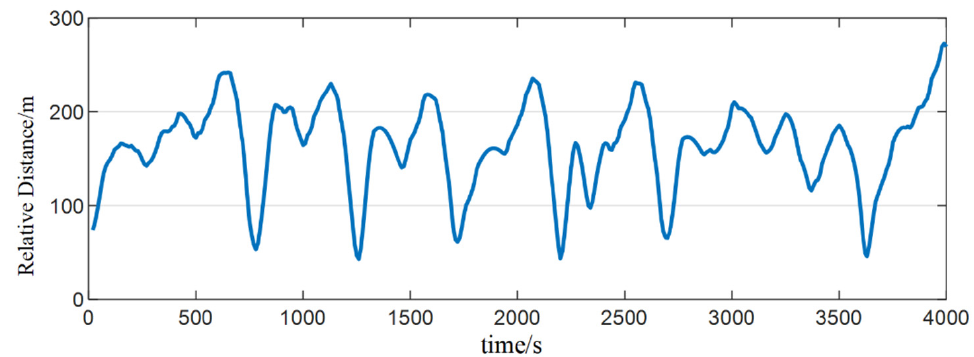
Figure 14. Relative distance between the master and slave AUVs.